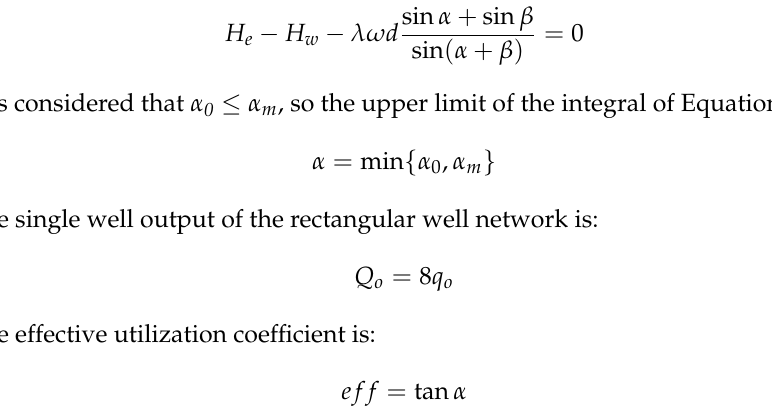
Figure 11. Rectangular well network after fracturing: ( a ) the entire well network; ( b ) the partition of a quarter of the well network.